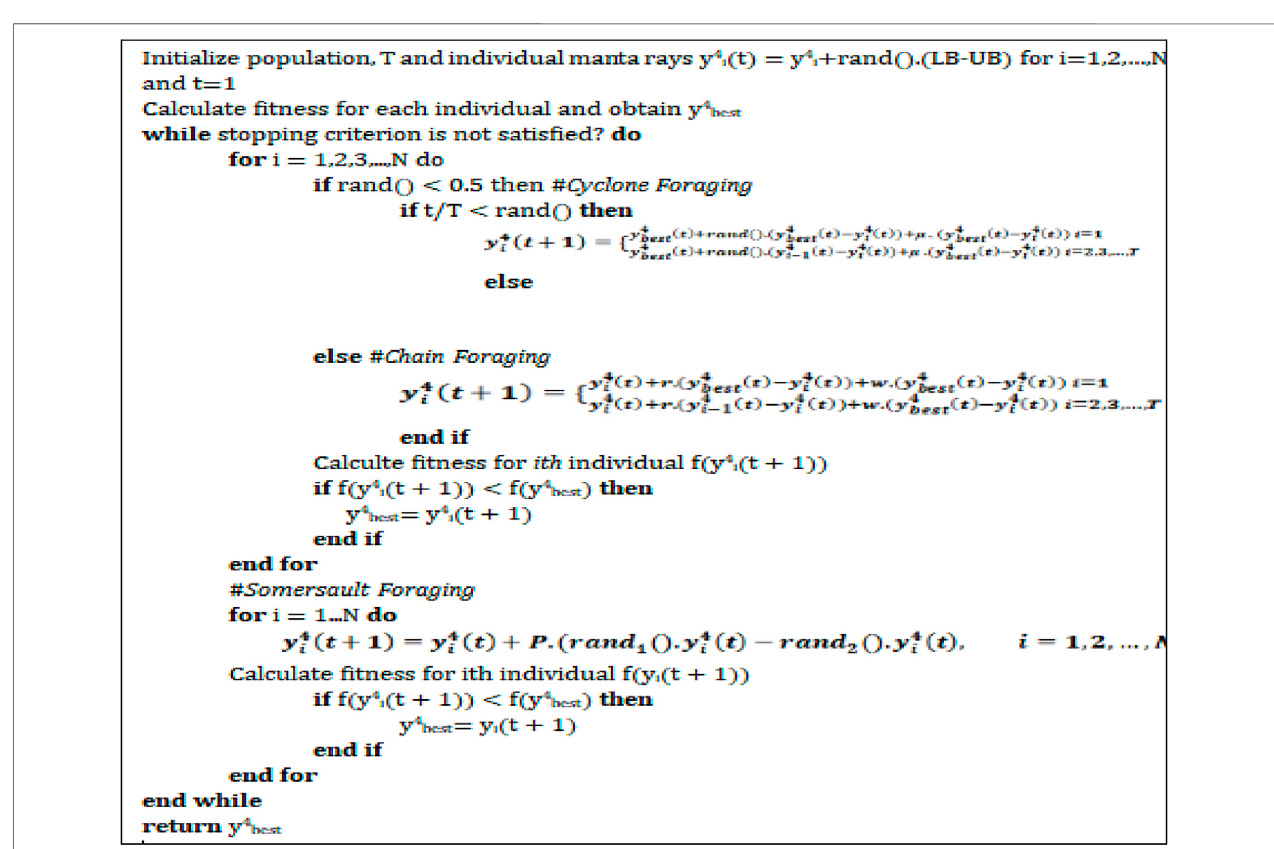
FIGURE 3 | Pseudocode of the MRF